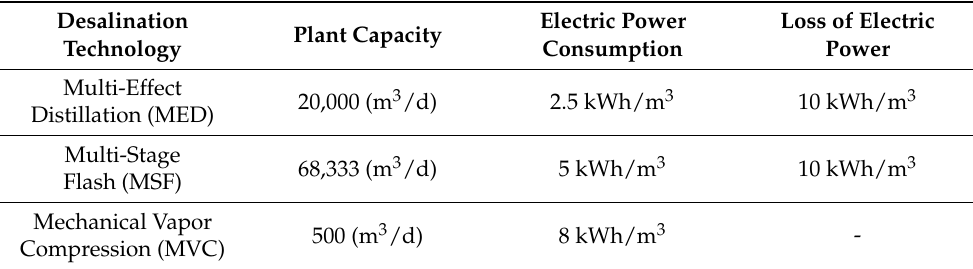
Table 3. Requirements and energy losses in thermal desalination